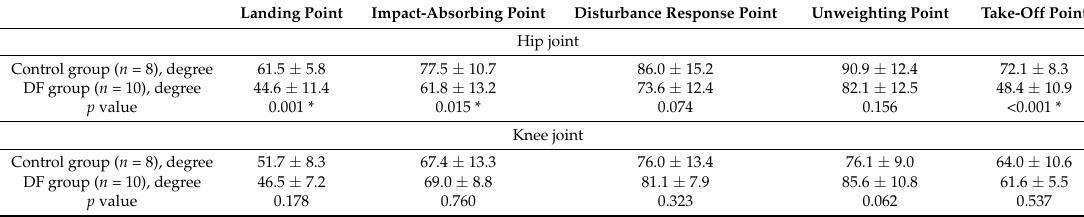
Table 4. Hip and knee flexion angles at each point.